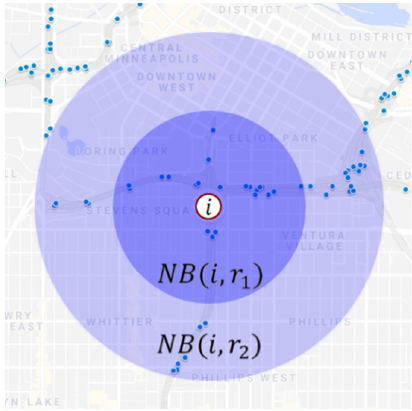
Figure 1. Two spatial neighborhoods.